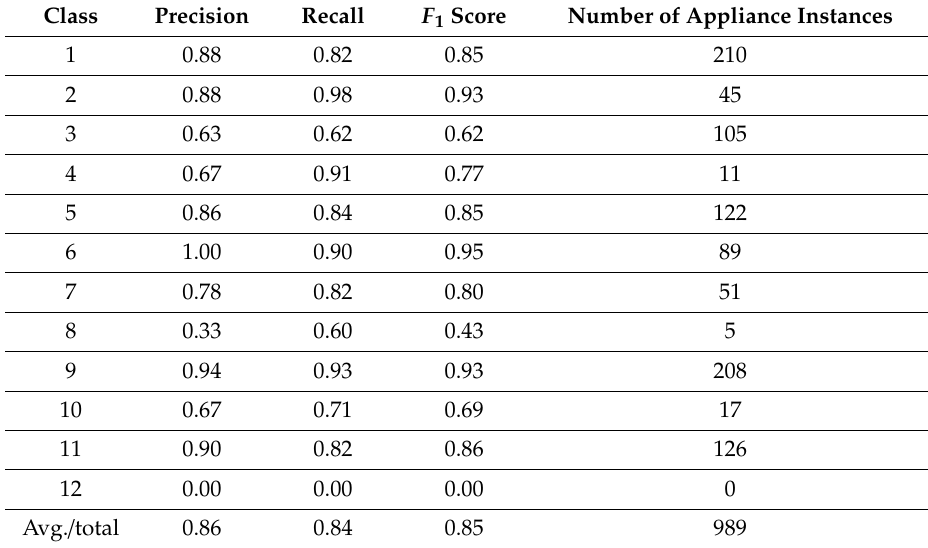
Table 8. Load recognition results obtained by the feed-forward ANN where it has been well trained and validated on the class-imbalanced training data.